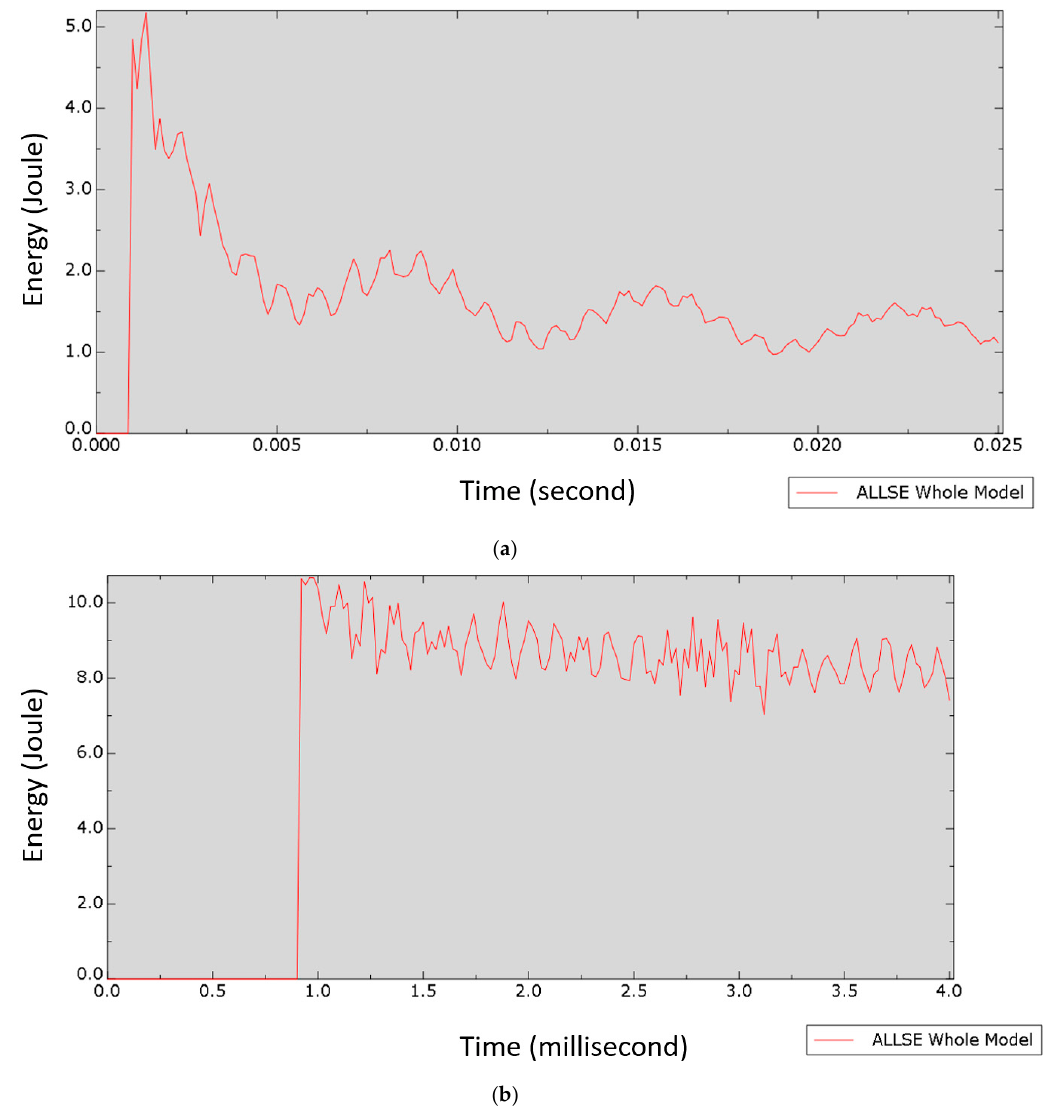
Figure 13. Comparison of strain energy during a pendulum impact test. ( a ) A regular plate; ( b ) A coconut-inspired plate.